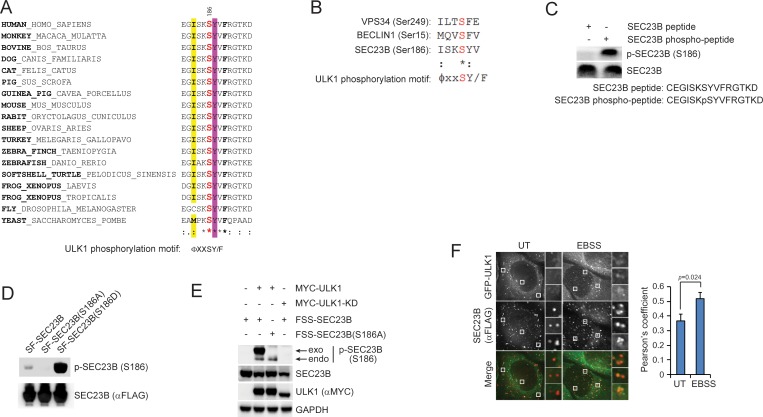
Characterization of the phospho-SEC23B (Ser186) antibody and the phospho-mimetic SEC23B mutant.(A) An ULK1 phosphorylation motif (ΦxxSY/F)(Egan et al., 2015) is highly conserved throughout evolution in the FBXW5-binding region of SEC23B. Φ, hydrophobic amino acids. (B) Sequence alignment of the previously characterized ULK1-substrates with SEC23B. (C) A non-phosphorylated SEC23B peptide and an equivalent phospho-peptide (sequences are indicated below the panels) were separated by SDS-PAGE and subjected to immunoblotting either with a phospho-specific SEC23B (Ser186) antibody or with an anti-SEC23B antibody reactive against both phosphorylated and non-phosphorylated species of SEC23B. (D) HEK239T cells were transfected with either SF- tagged SEC23B or the indicated SF-tagged SEC23B mutants. Twenty-four hours after transfection, cells were immunoblotted as indicated. (E) HEK293T cells were transfected with either FLAG-Streptag-Streptag-tagged SEC23B or FLAG-Streptag-Streptag-tagged SEC23B(S186A) in combination with MYC-tagged ULK1 or MYC-tagged ULK1-KD as indicated. Twenty-four hours after transfection, cells were harvested for immunoblotting as indicated. exo and endo indicate the exogenous and endogenous SEC23B, respectively. (F) U-2OS cells stably expressing GFP-ULK1 were transfected with FLAG-HA-tagged SEC23B. Twenty-four hours after transfection, cells were fixed for immunofluorescence as indicated. Images were analysed by ImageJ with at least 100 cells counted per sample. Quantification of SEC23B overlapping with GFP-ULK1 was performed using the Pearson's correlation coefficient. The data are presented as mean ±SD (right panel). Scale bar, 10 μm.
10.7554/eLife.42253.007Figure 2—figure supplement 1—source data 1.Source data for panel F.